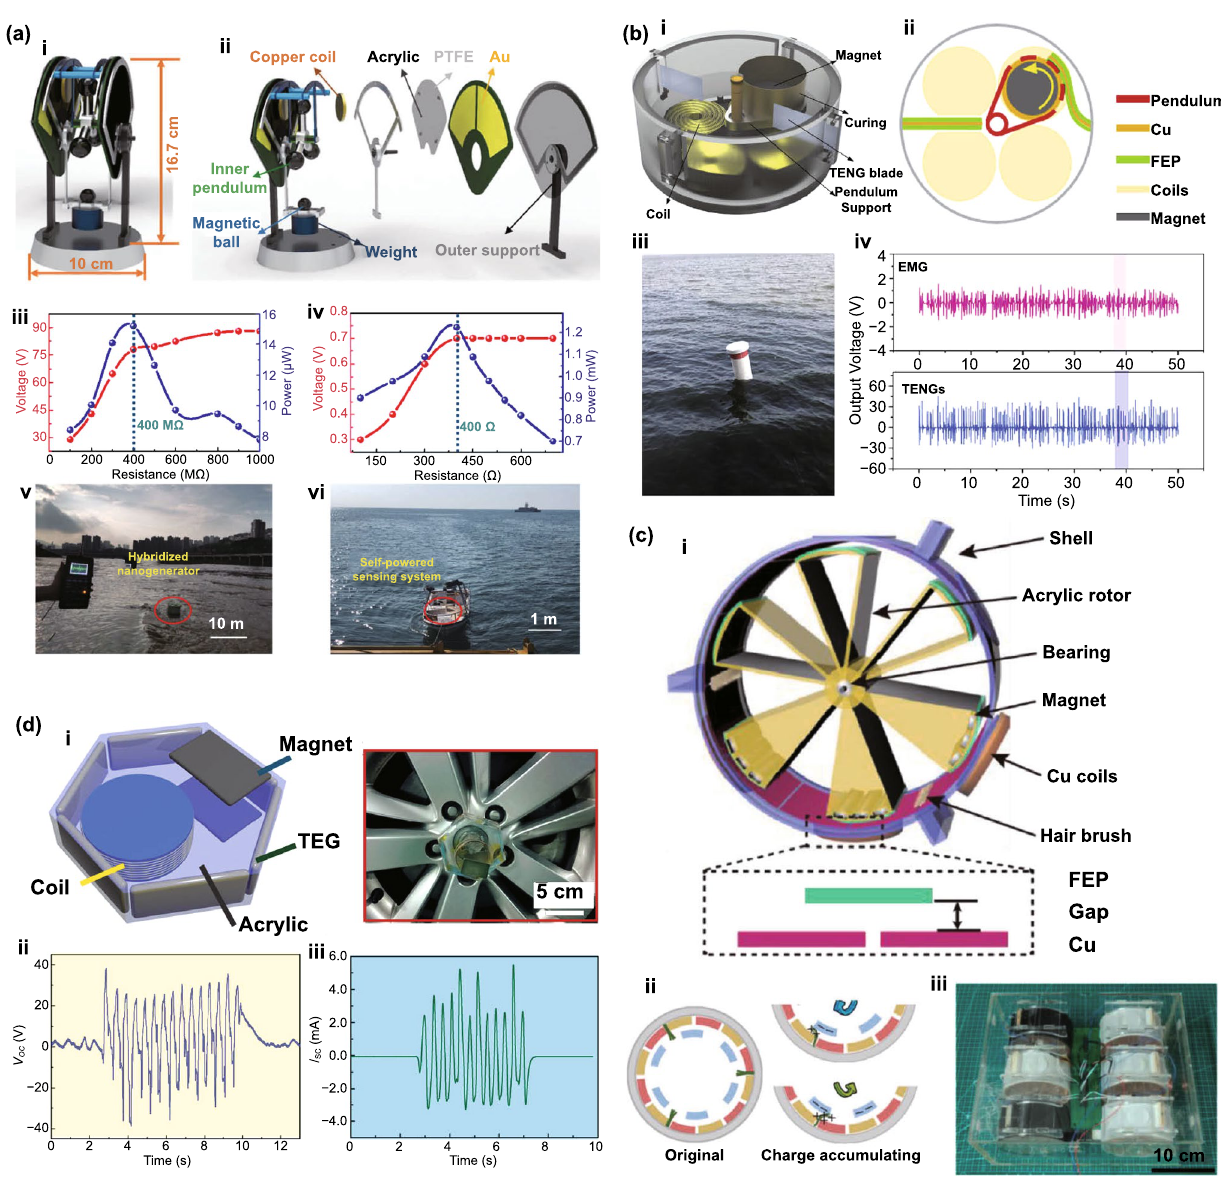
Fig. 14 a (i) Structural schematic diagram and (ii) exploded view of the chaotic pendulum hybridized nanogenerator designed by Chen et al. Dependences of the output voltage and power of the (iii) TENG and (iv) EMG with the load resistance. (v) Hybridized nanogenerator being tested in a lake. (vi) Self-powered wireless sensing node transmission system enabled by the hybridized nanogenerator in a boat. Reproduced with permission from Ref. [74]. Copyright 2019, Elsevier Ltd. All rights reserved. b (i) Schematic illustration and (ii) top view of the structure diagram of the rotational pendulum hybrid generator developed by Hou et al. (iii) Photograph of the hybrid generator inside a buoy being tested in a lake and (iv) output voltage of the EMG and TENG units when horizontally placed. Reproduced with permission from Ref. [75]. Copyright 2019, Elsevier Ltd. All rights reserved. c (i) Schematic illustration of the soft-contact cylindrical hybrid nanogenerator developed by Feng. et al. (ii) Working principle of the free-standing TENGs with FEP/Cu layers and rabbit hair brushes. (iii) Photograph of the hybrid array device with 6 units demonstrated in hydrological monitoring by water wave energy harvesting. Reproduced with permission from Ref. [76]. Copyright 2021, Nano Energy. d (i) Schematic illustration and photograph of the hybrid E-TENG tested by Fan et al. It is composed by six TENGs and one EMG units fixed to an automobile tire. (ii) Output OC voltage and (iii) SC current measured during rotation of the tire. Adapted from Ref. [77]. (Color figure